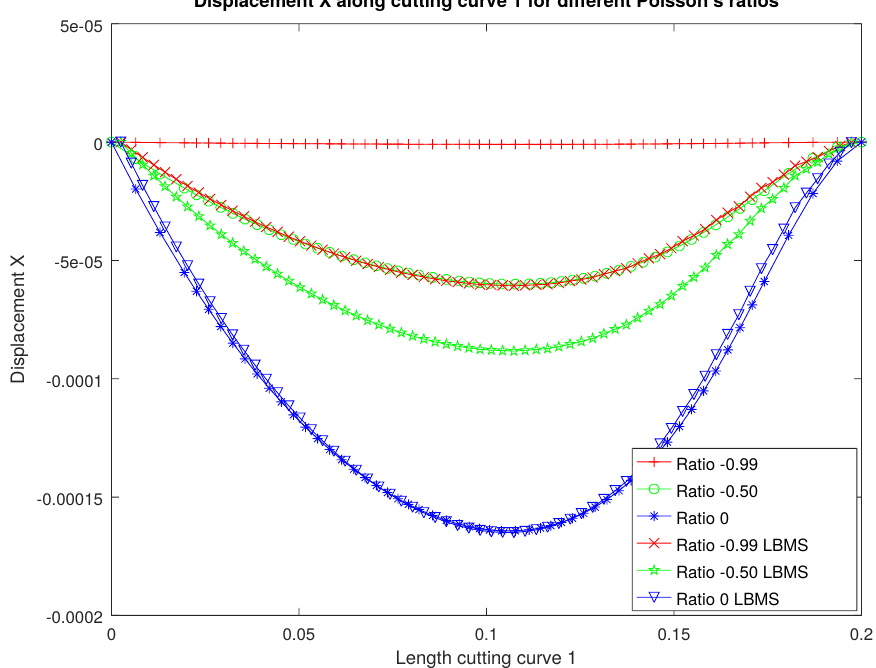
Figure A4. First displacement components along cutting curve C 1 for negative Poisson’s